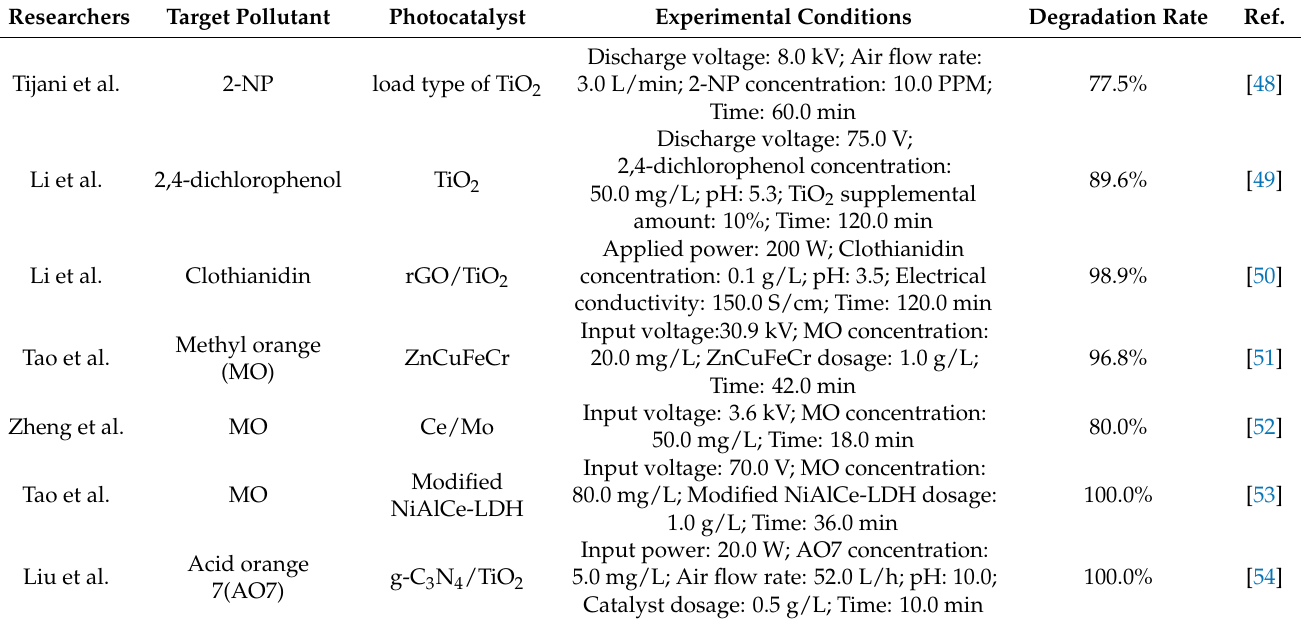
Table 1. Energy efficiency and synergetic